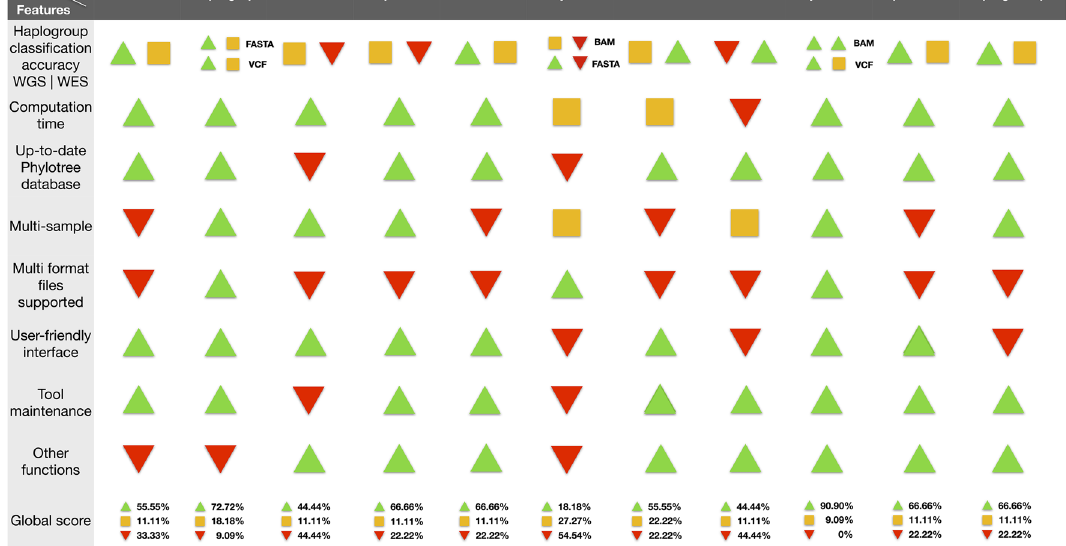
Table 2. Qualitative assessment of mtDNA haplogroup classification tools. Performance of each tool is evaluated across different features and represented on a color scale based on the level of performance: green triangle pointing up for good, orange square for fair, and red triangle pointing down for low performance. Haplogroup classification accuracy of each tool was categorized into three ranges based on the predicted probabilities by each application: tools with a predicted probability of incorrectly classifying a haplogroup below 1% were represented as good performance, for a fair performance was established a range between 1.01% and 10%, and as low performance tools with a predicted probability higher than 10.01%. For computation time, three intervals were established: tools that classified samples in less than a minute were defined as good performance, from 1 to 5 min were categorized as fair performance, and those tools that required more than an hour were represented as low performance. Regarding the PhyloTree database used, it was represented as low performance those tools which are not updated to the latest version of Phylotree, Build 17, and those that allow the latest version as high performance. Multi-sample function was evaluated based on the possibility of cohort analysis. Tools that allow to process these functions were defined as good performance, tools that allow processing several samples by using a loop through a command-line were categorized as fair performance, and tools without this ability were represented as low performance. Based on the file format supported two categories were established: tools that support various input format files categorized as high